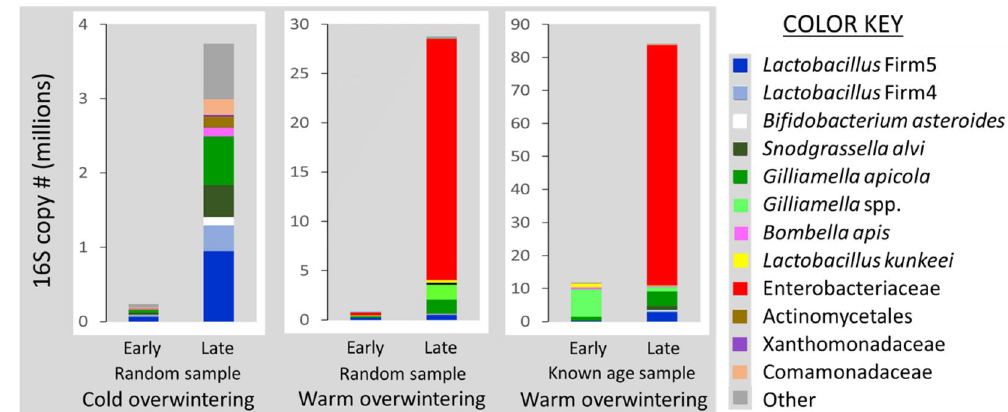
Figure 6. Mean normalized abundance of the midgut microbiota by overwintering environment and sample set. Worker bees were sampled in early or late winter. Random samples are in-hive worker bees of unknown age selected from around the brood nest ( n = 16 per time point). Known age samples are aged 19/33 days (early, n = 16) and 50/70 days (late, n = 22). Normalized abundance values for each y-axis are in millions and differ significantly by sample set. See “Methods” for detailed